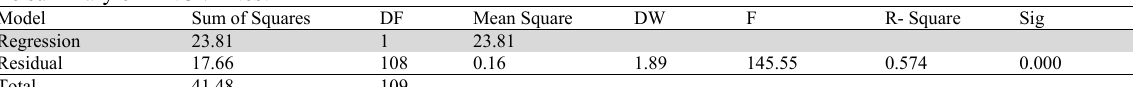
The summary of ANOVA